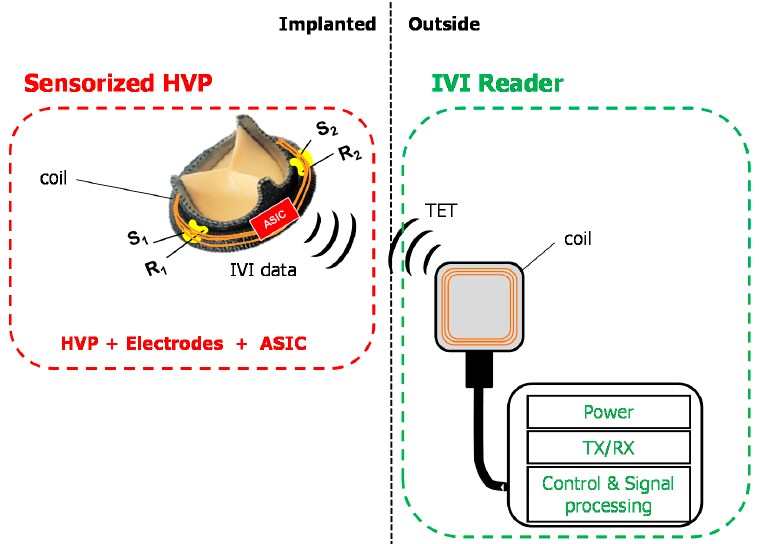
Figure 7. Scheme of the overall design for an implantable sensorized HVP for IVI sensing.